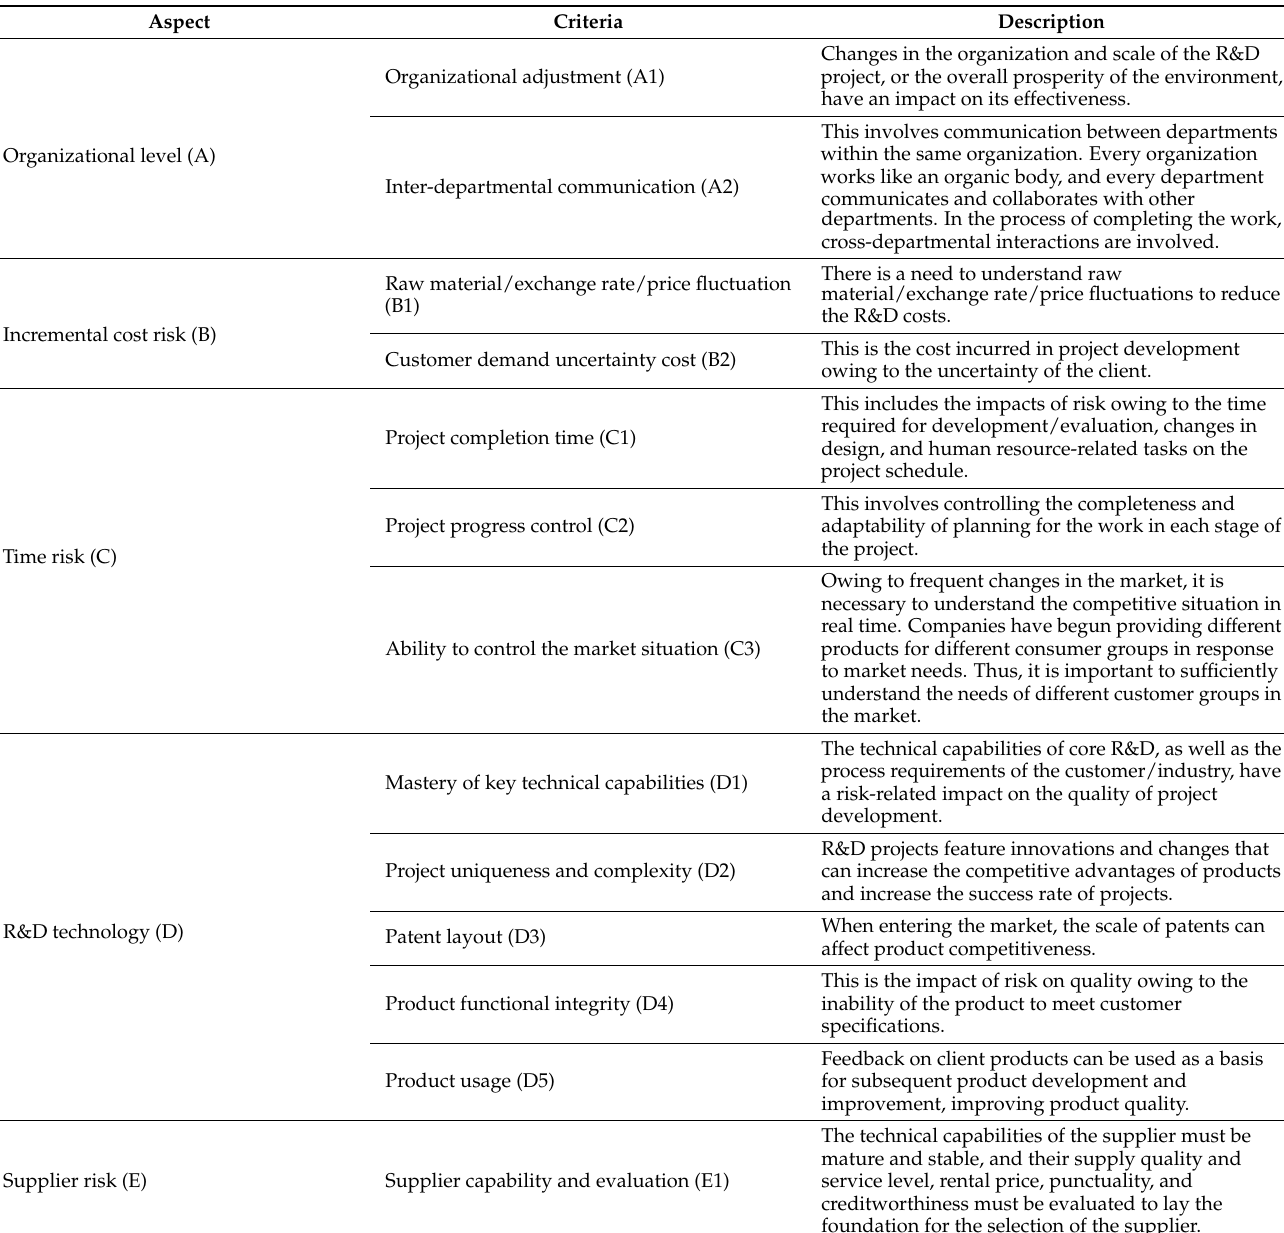
Table 5. Aspects and criteria of the formal